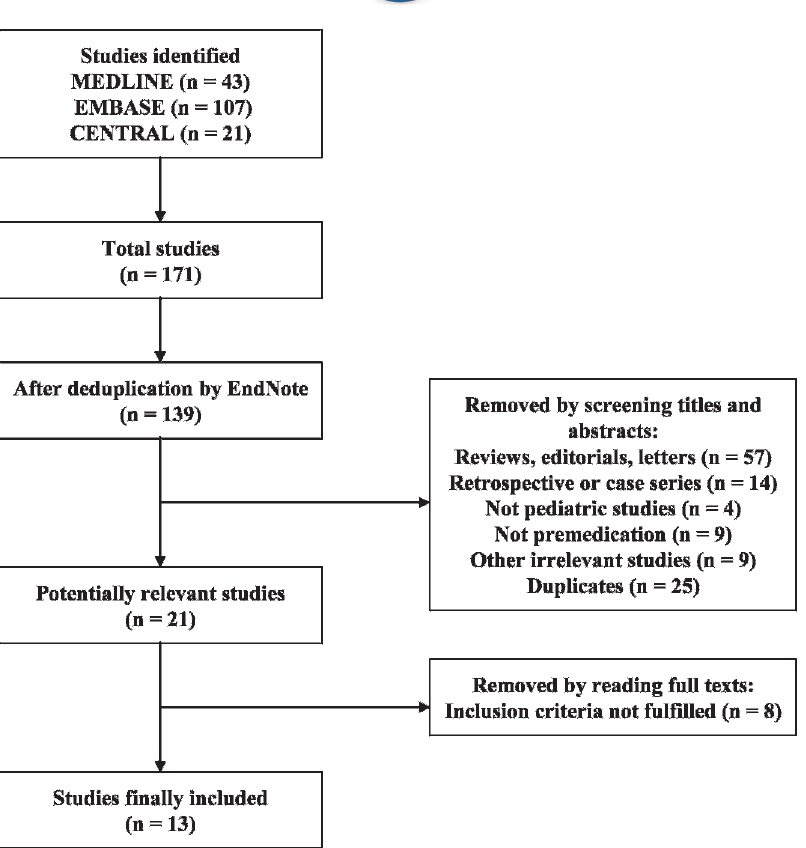
Figure 1 - Flow chart of retrieved, excluded and included trials.